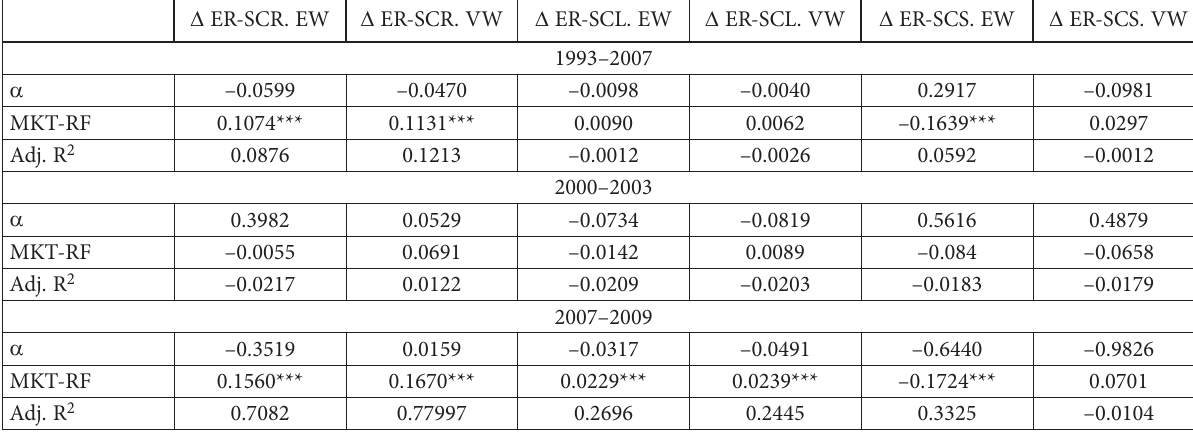
Table 5. Statistical margin of difference with CAPM